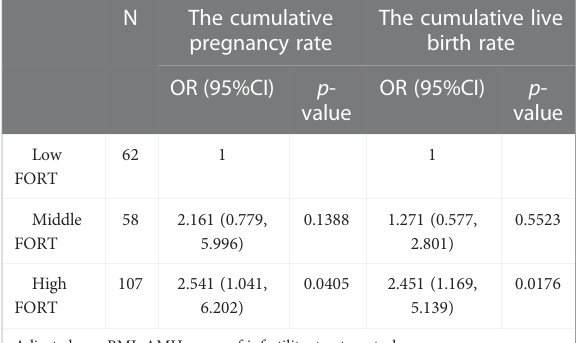
TABLE 8 Strati fi cation analysis of follicular output rate and cumulative clinical